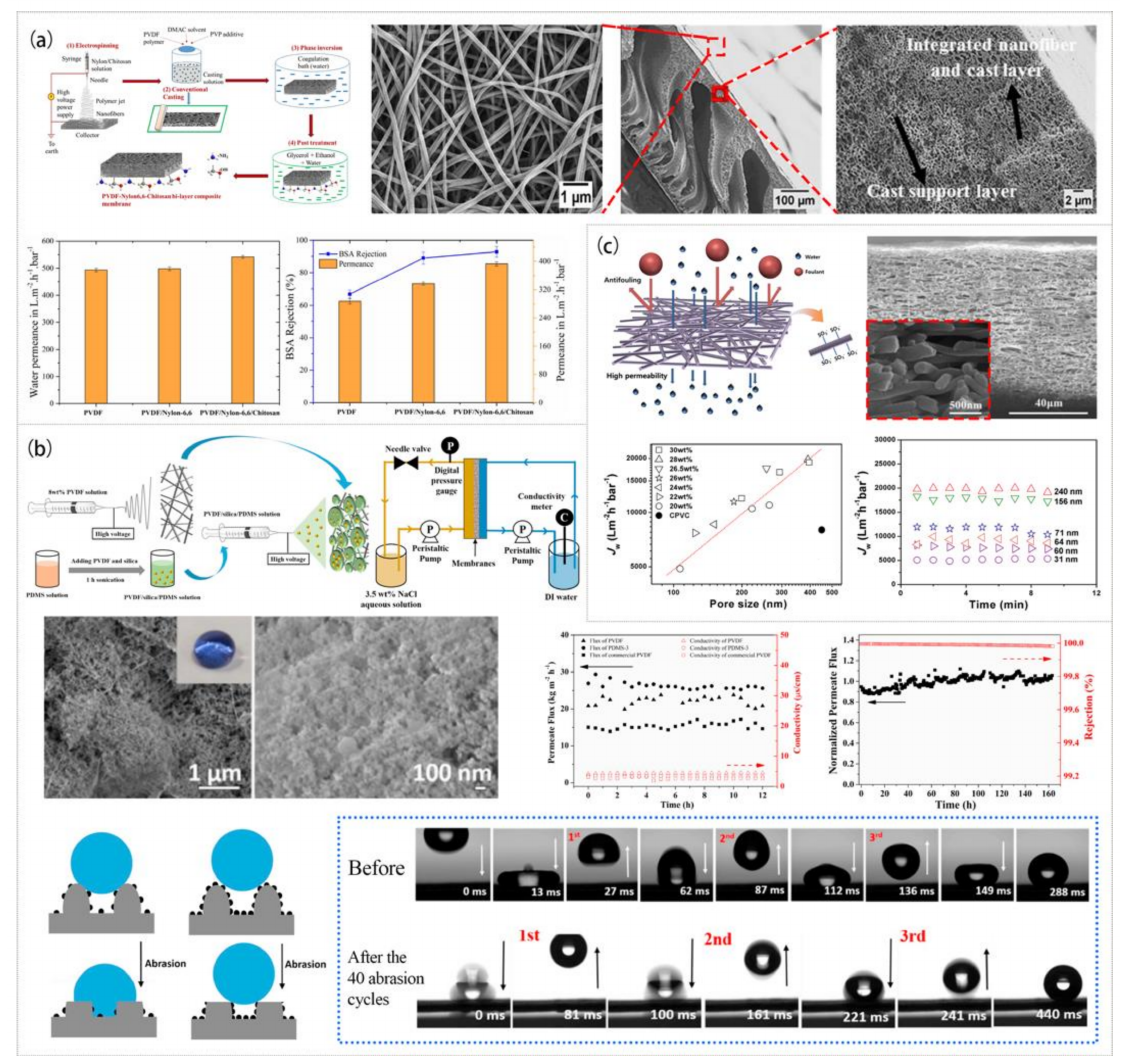
Figure 11. Preparation process, microstructure, and properties of related antifouling membranes: ( a ) PVDF/nylon-6,6/CS nanofiber UF membrane. Reprinted with permission from Ref. [183]. Copy- right 2017 American Chemical Society. ( b ) PVDF/PDMS/silica MD membrane. Reprinted with permission from Ref. [186]. Copyright 2020 Elsevier Ltd. ( c ) PVDF/Nafion nanofiber NF membrane. Reprinted with permission from Ref. [187]. Copyright 2014 American Chemical